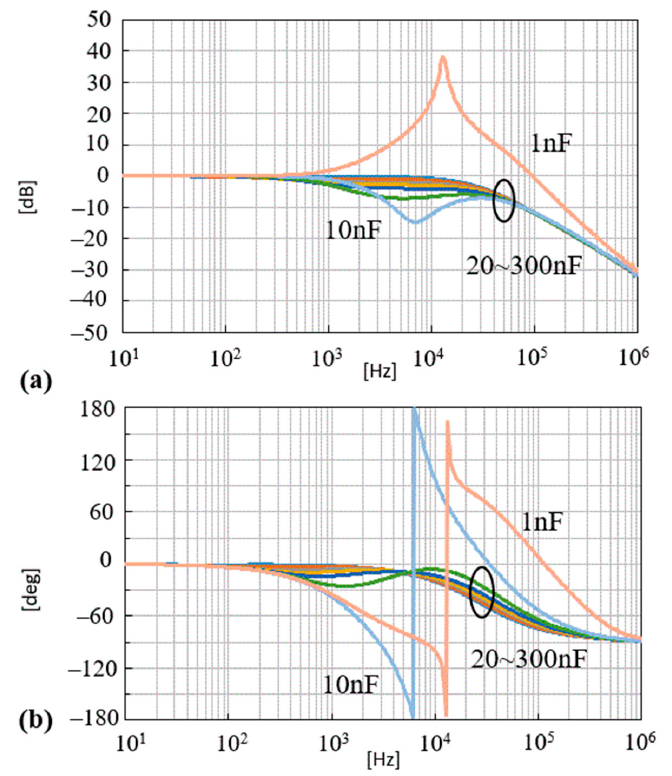
Figure 7. Bode plots with C VDD varied. ( a ) Gain vs. freq.; ( b ) Phase vs. freq.